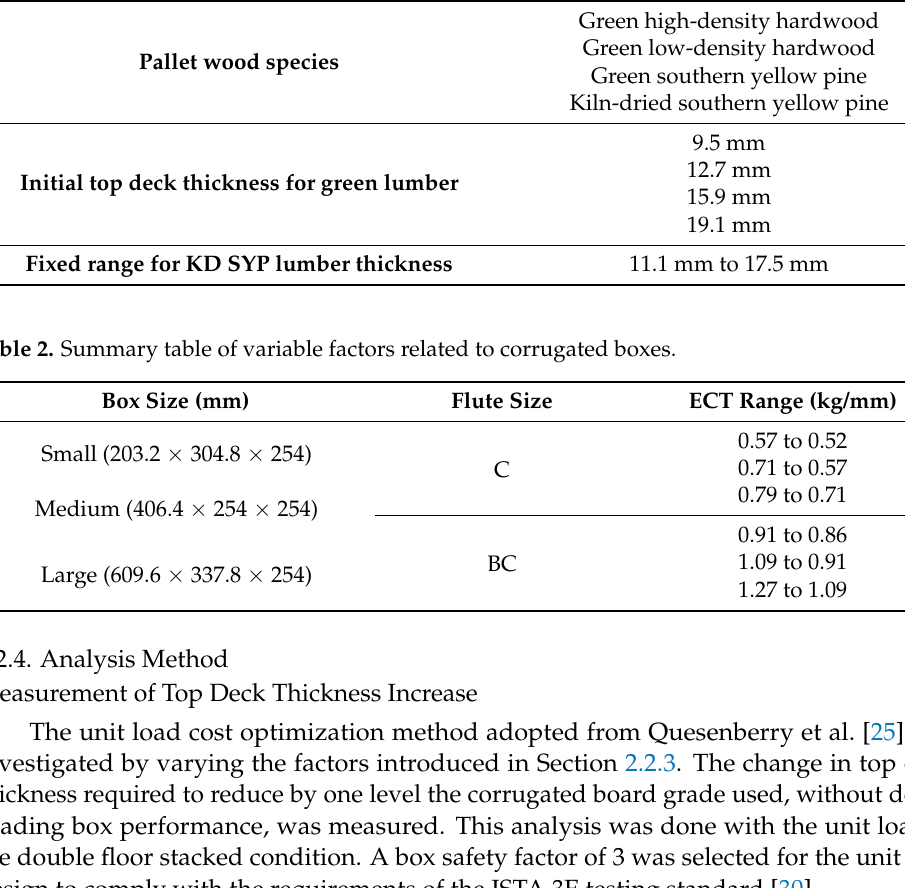
Table 1. Summary table of variable factors related to pallets.